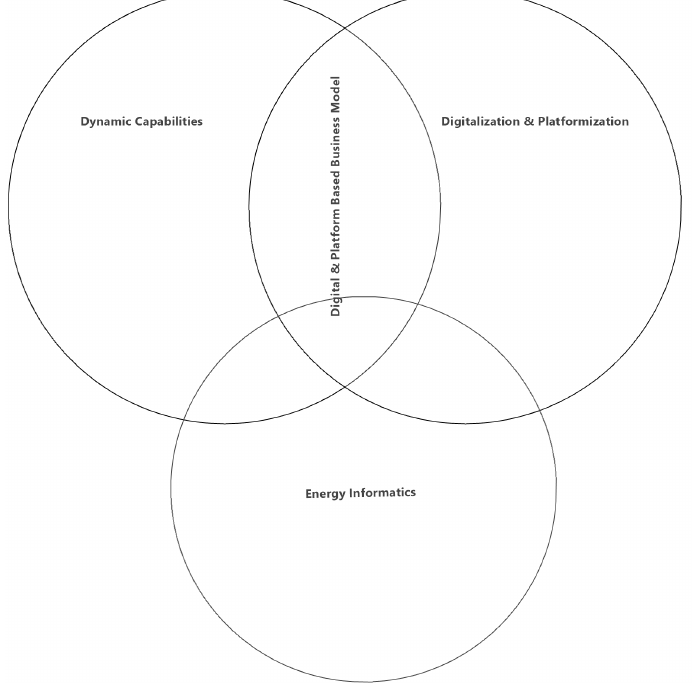
Figure 2. Research